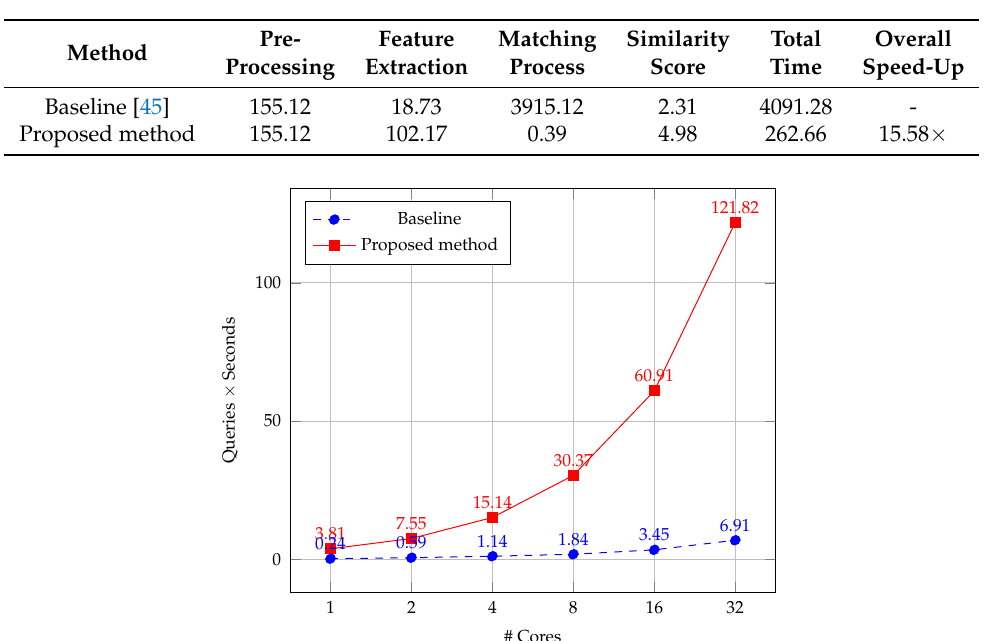
Table 7. Comparison of execution time of each process of the recognition pipeline. All times are given in milliseconds (ms).